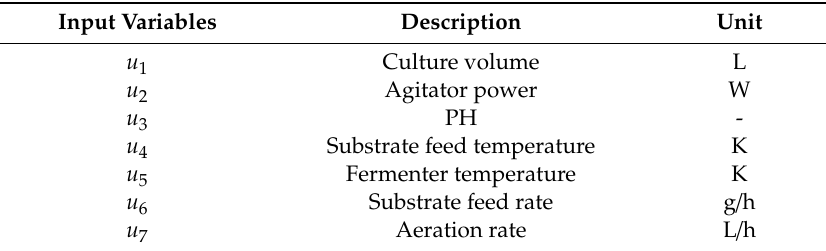
Table 1. Input variables selected in